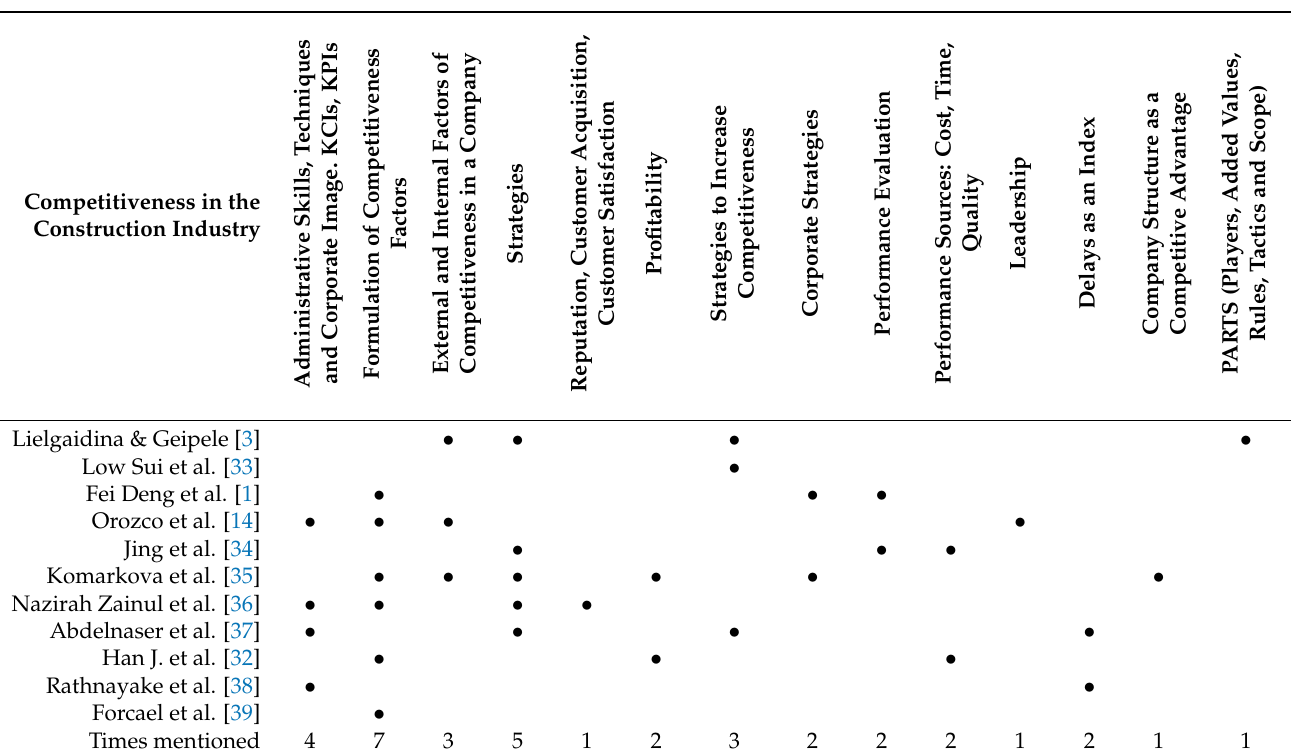
Table 2. The concept of competitiveness in the Construction